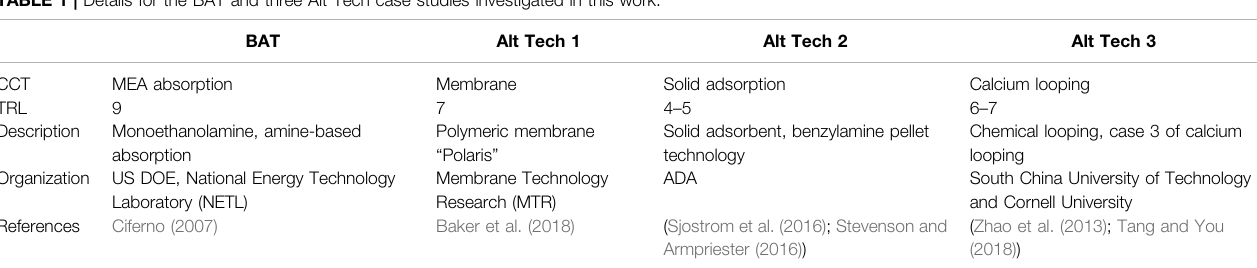
TABLE 1 | Details for the BAT and three Alt Tech case studies investigated in this